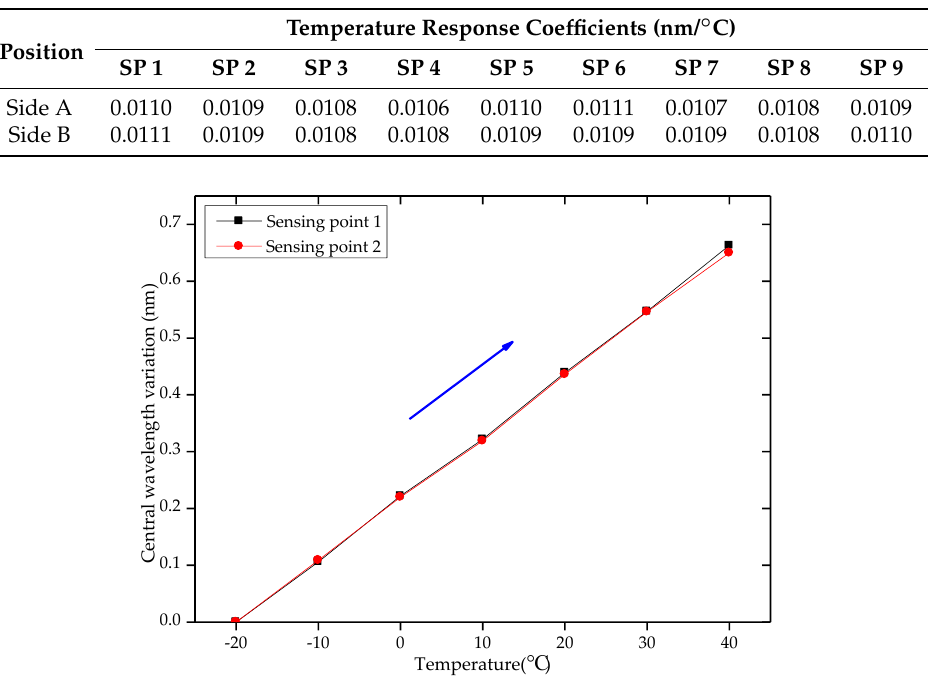
Figure 5. Temperature response characteristics curves of two sensing points.